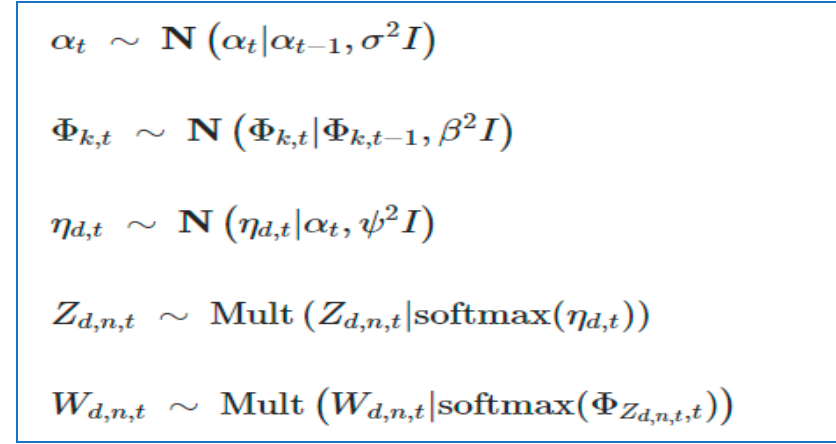
Figure 3. DT model formula. Figure 3. DT model